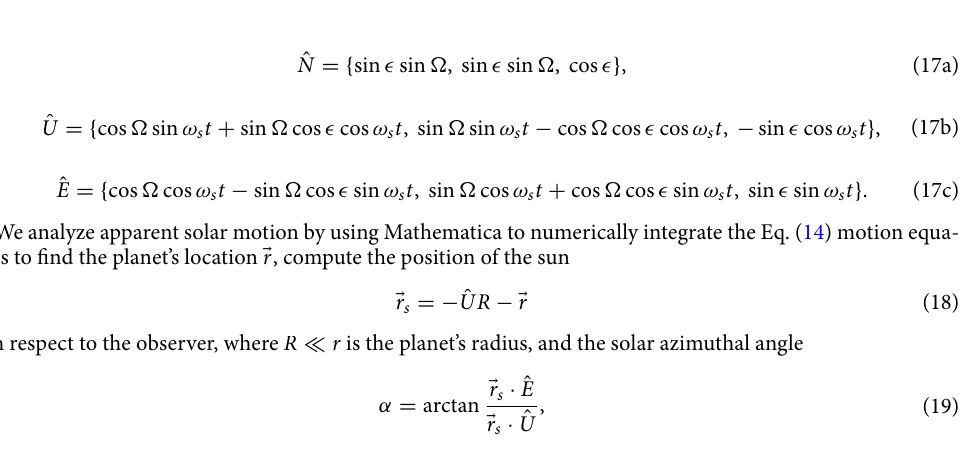
Figure 4. Mercury coil plot. On Mercury, one (solar) day lasts two years, and an equatorial observer (red) witnesses a small solar reversal (cyan) once a